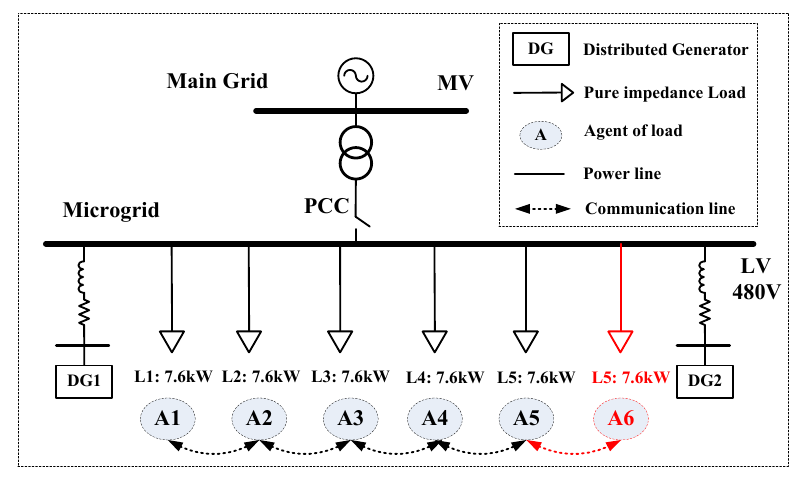
Figure 2. Simulated